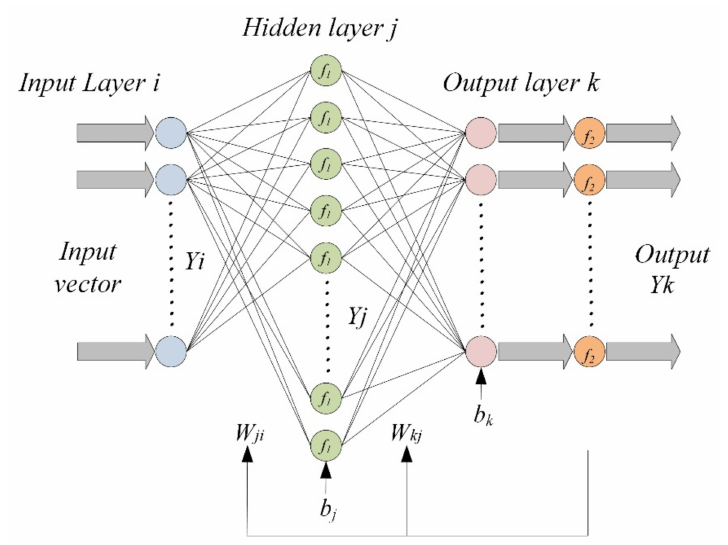
Figure 3. Three-layer feed-forward network